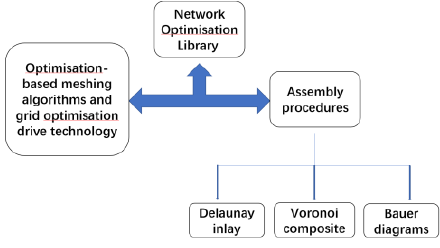
Figure 6 . Composition of the optimization library